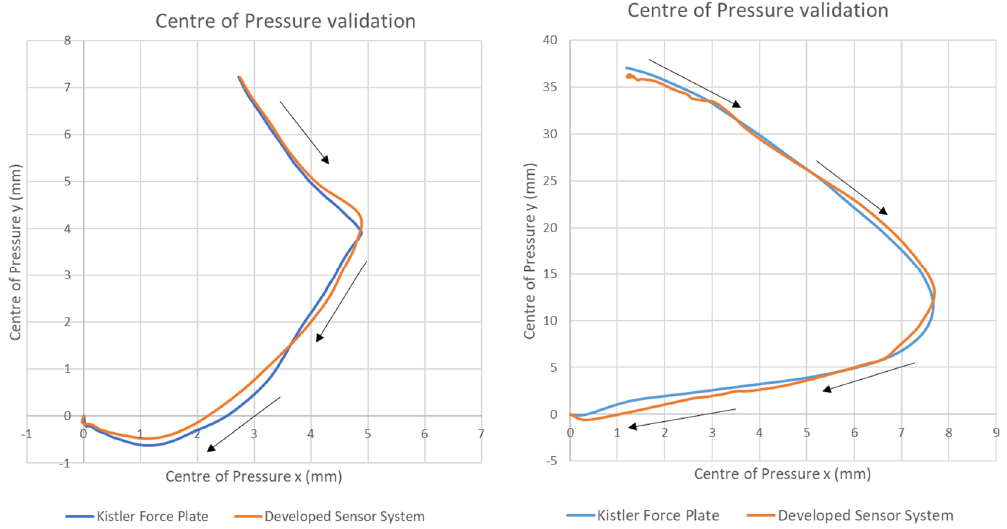
Table 1. Pearson correlation coefficient and root mean square error for centre of pressure validation.